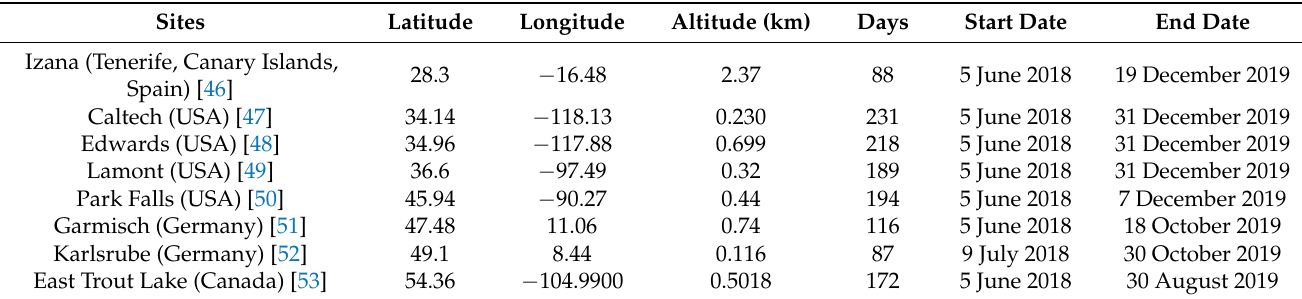
Table 1. Information for the Total Carbon Column Observing Network (TCCON) stations used for the validation. Sites